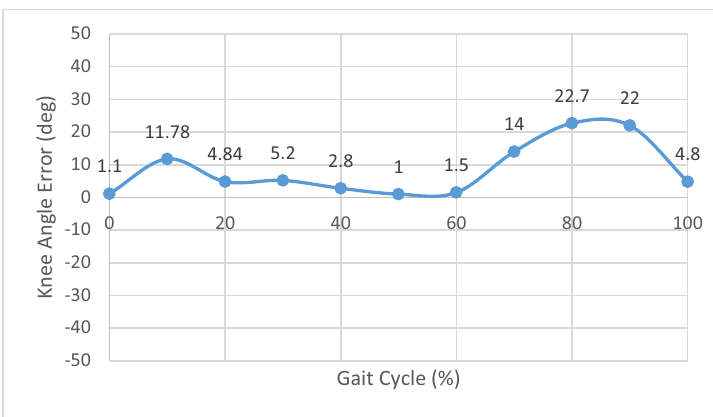
Figure 26: Error data of knee angle simulation.